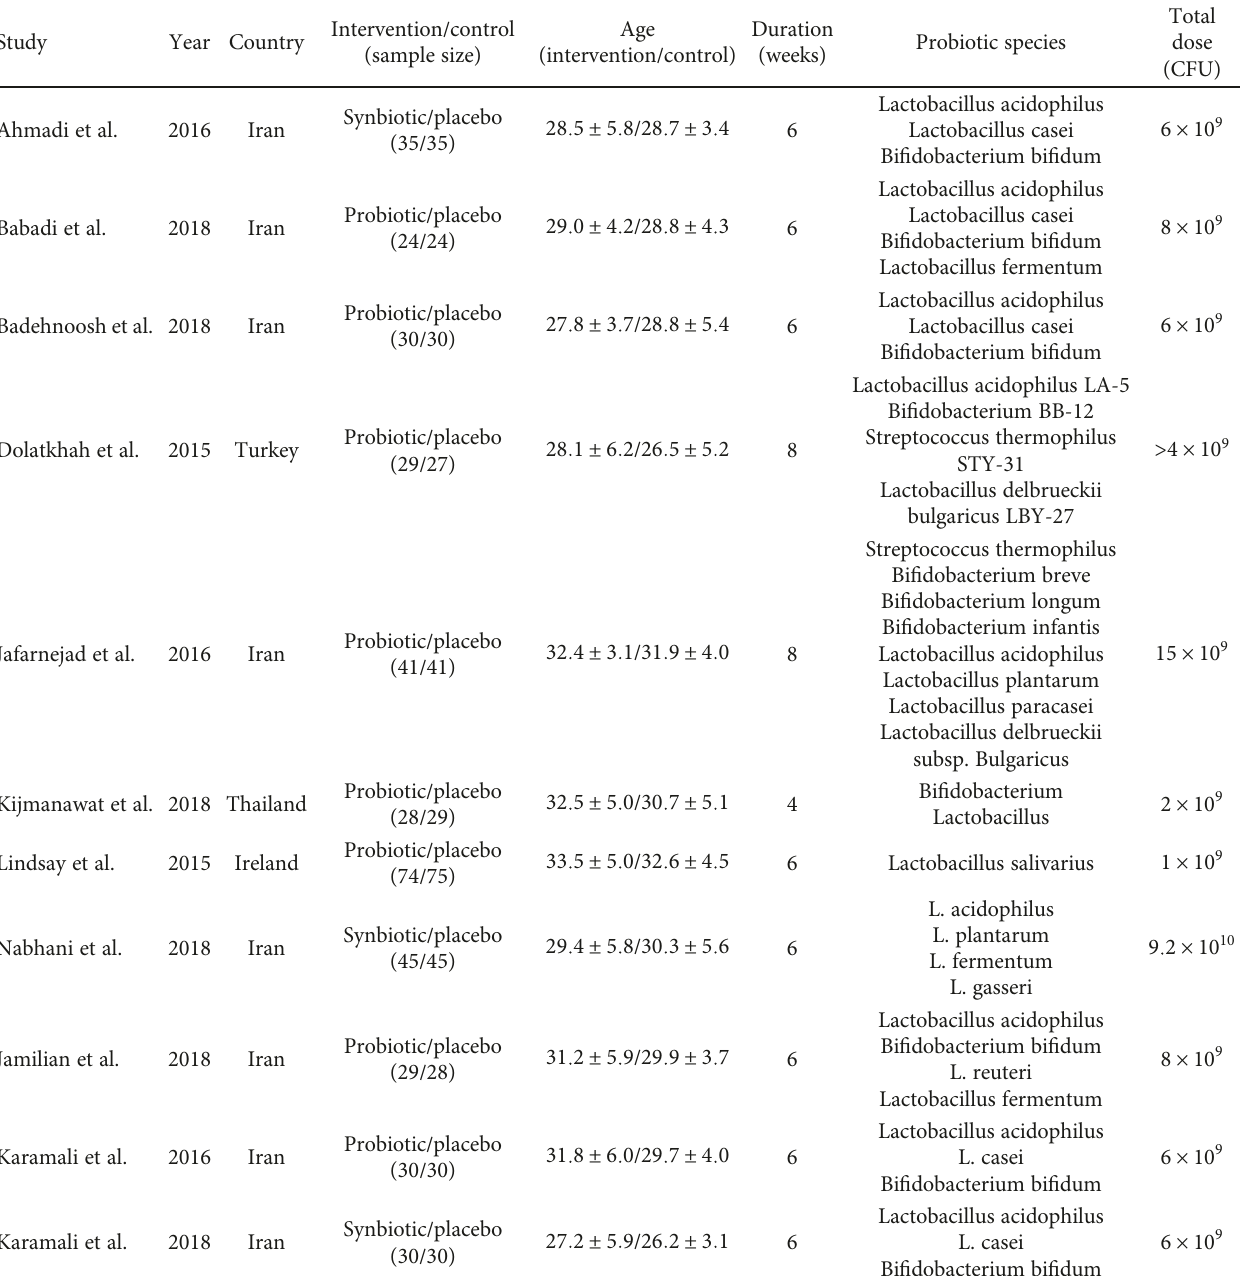
Table 1: Characteristics of the included